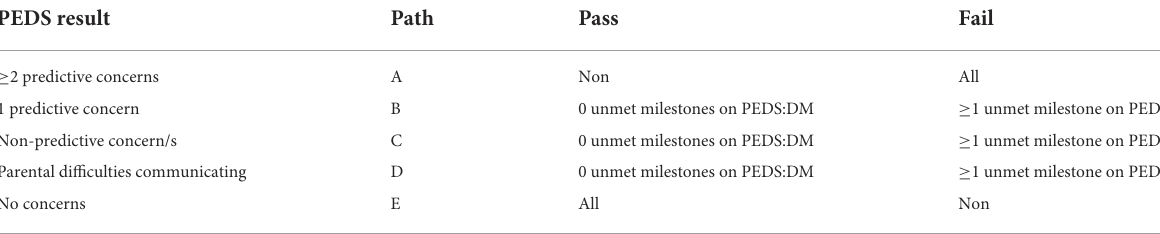
TABLE 1 Pass and fail criteria of Parents’ Evaluation of Developmental Status (PEDS)